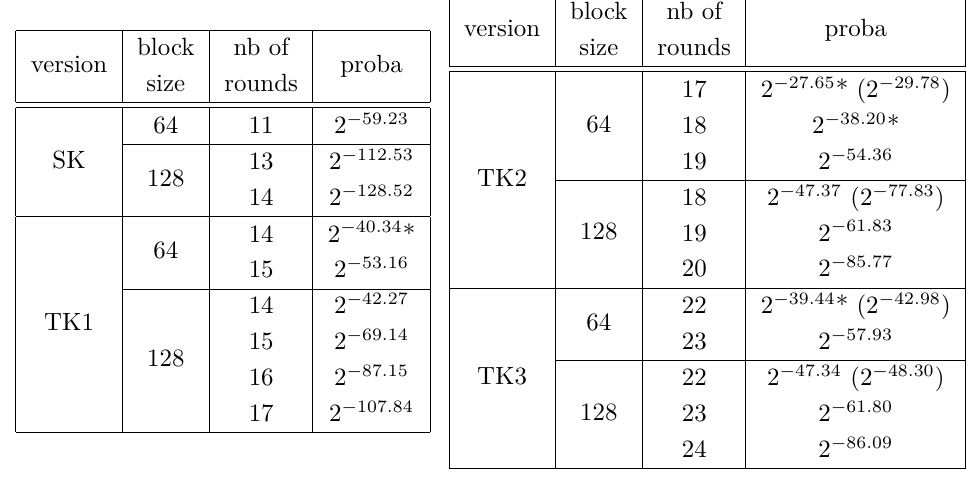
Table 1: Results for different versions and number of rounds on skinny . Probabilities marked with asterisks have been validated experimentally. The four previous results from [SQH19] are also given in